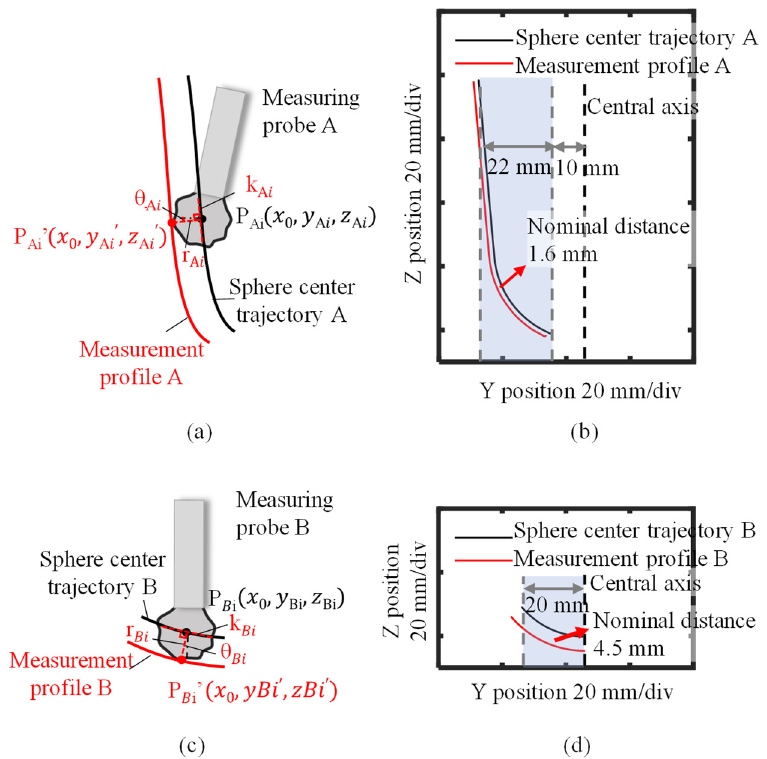
Figure 17. Schematic and experimental results of evaluating the inner profile of the high aspect ratio aspheric workpiece. ( a ) Schematic of evaluating the inner sidewall profile; ( b ) experimental results of evaluating the inner sidewall profile; ( c ) schematic of evaluating the inner underside profile; ( d ) experimental results of evaluating the inner underside profile.